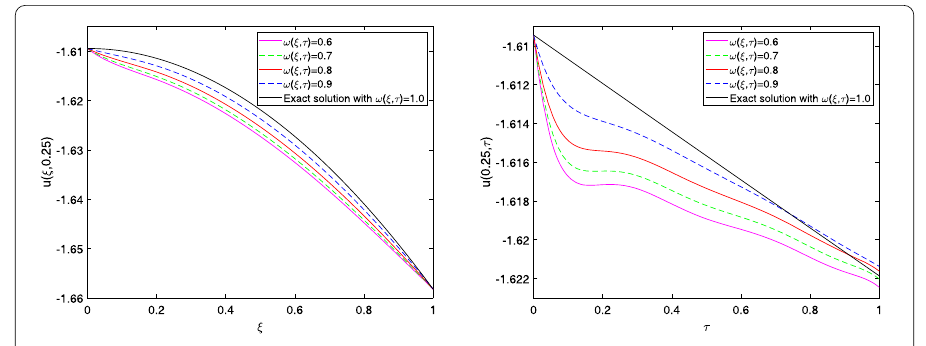
Figure 1 Behavior of the numerical solutions u ( ζ ,0.25) (left) and u (0.25, τ ) (right) for some functions ω ( ζ , τ ) in Example 1